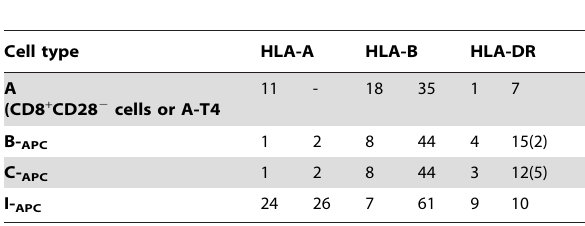
Table 1. Representative HLA typing of donors used for experiments demonstrating HLA class I antigen specificity shown in Figure